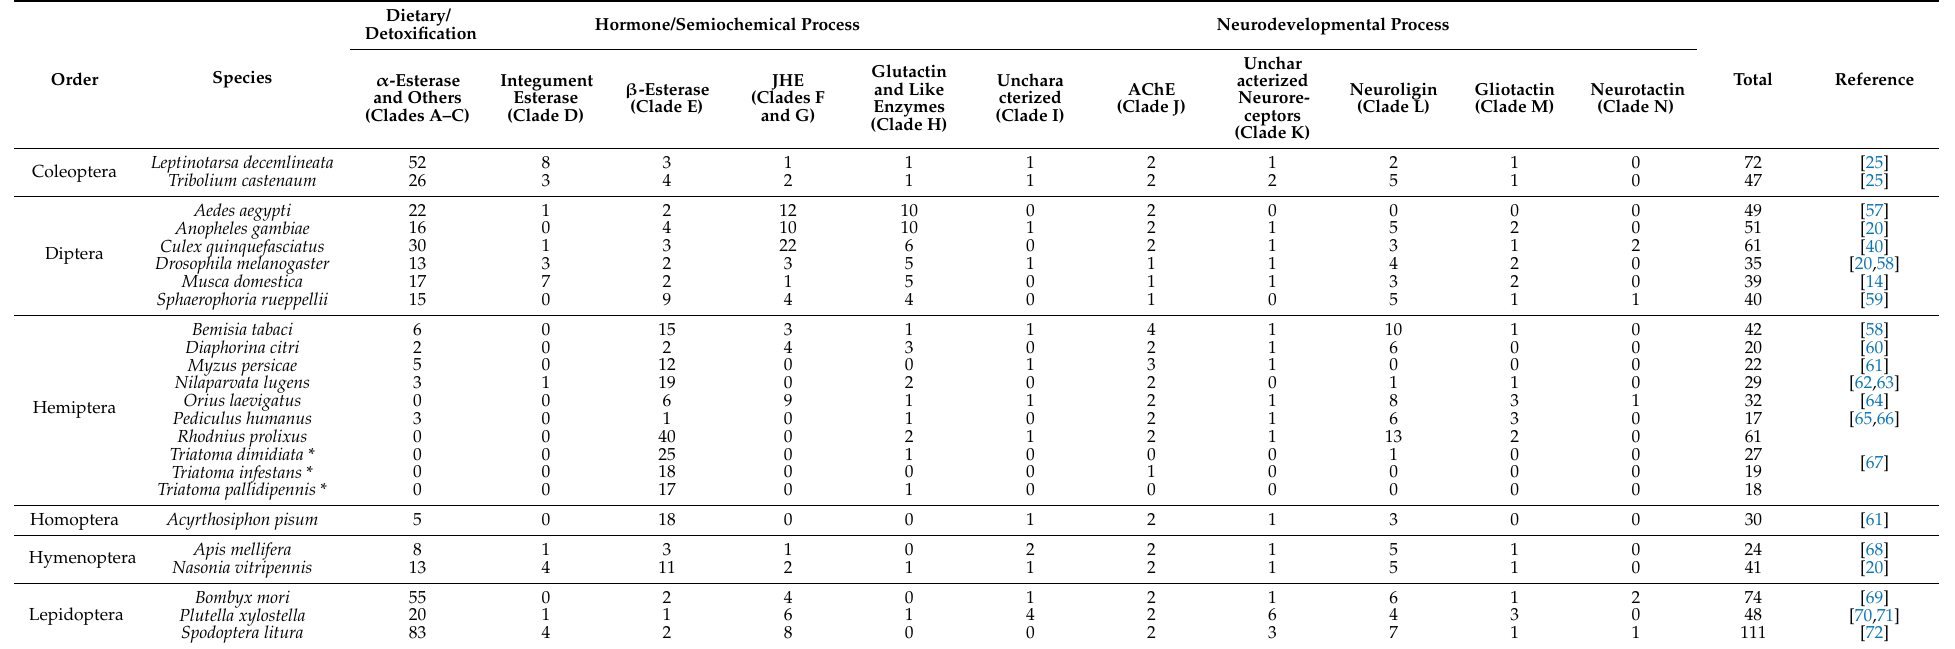
Table 1. The information of CCE genes in 24 insect